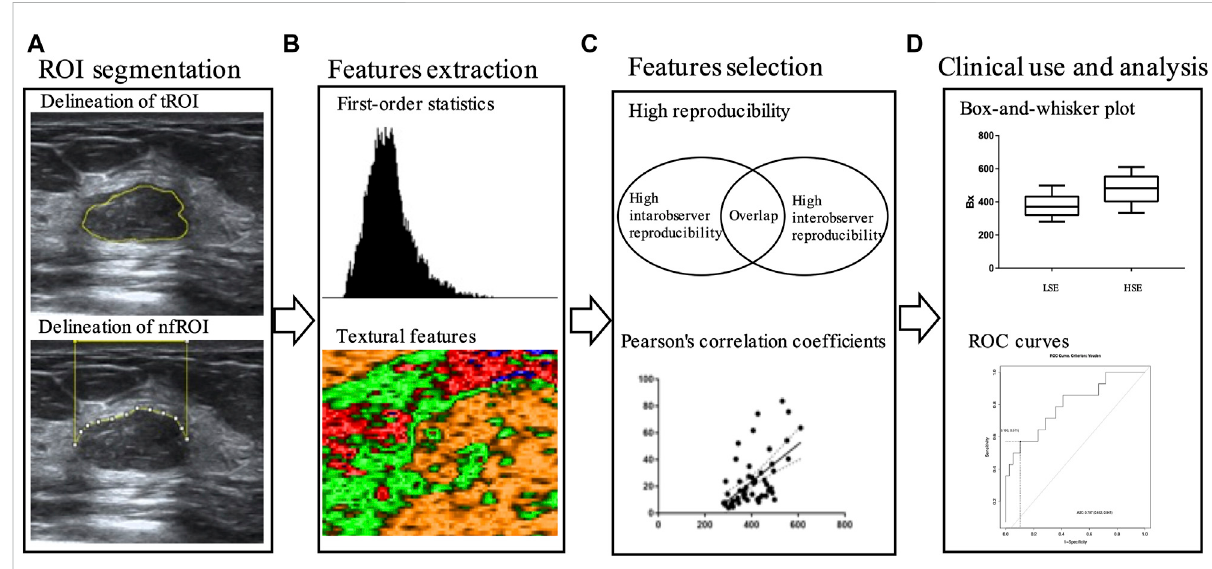
FIGURE 3 Work fl ow of main steps: (A) tROI and nfROI segmentation, (B) ultrasound radiomics features extraction with ImageJ, (C) features selection and (D) ROC analysis. tROI, region of interest of tumor; nfROI, region of interest of near fi eld; LSE, low sonication energy; HSE, high sonication energy; ROC, receiver operator characteristic.